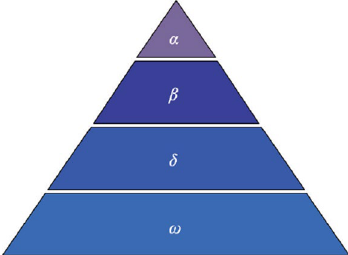
Figure 1. Grey Wolf social